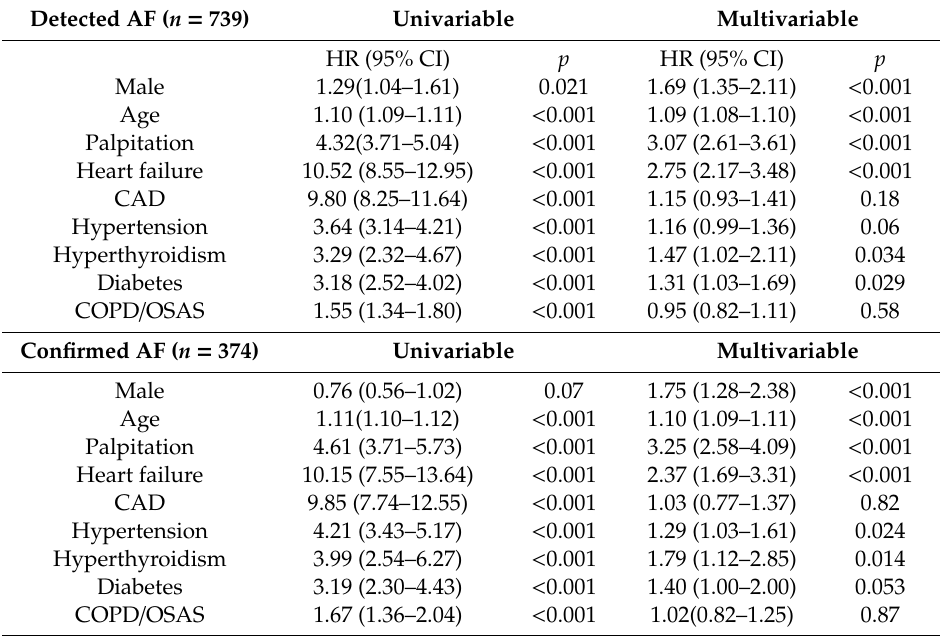
Table 5. Univariable and multivariable hazard ratios for detected AF in 209,274 subjects.